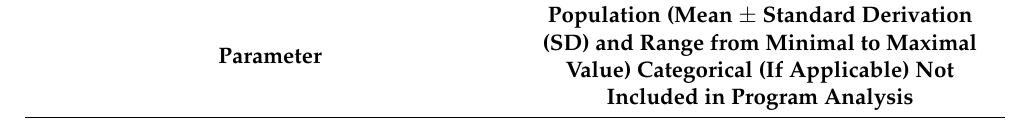
Table 1. Basic characteristics of the